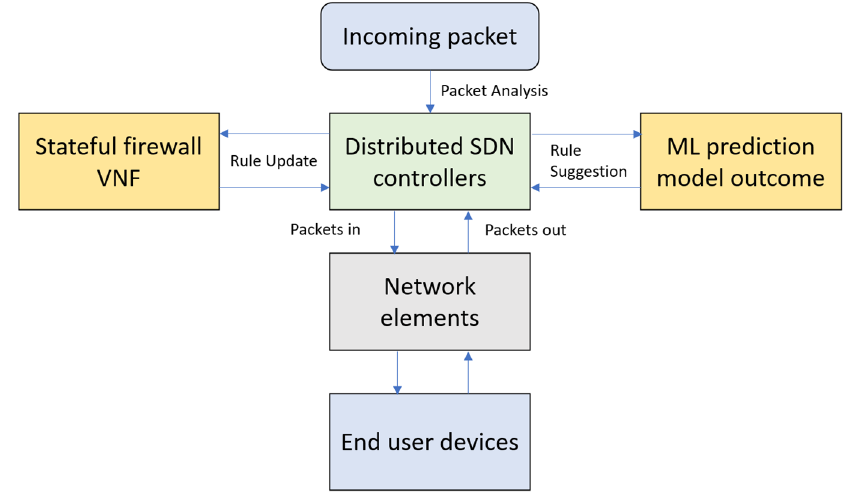
Figure 7. Flow of proposed SDNFV